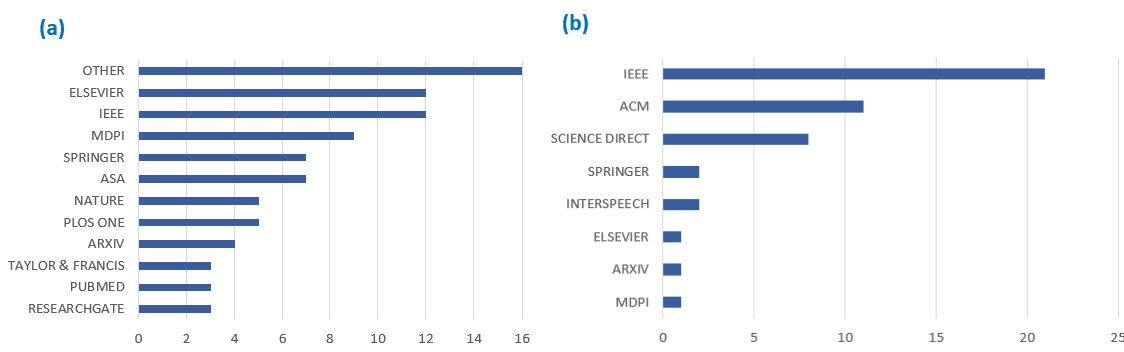
Figure 4. Databases used to retrieve ( a ) bioacoustics and ( b ) general acoustics classification